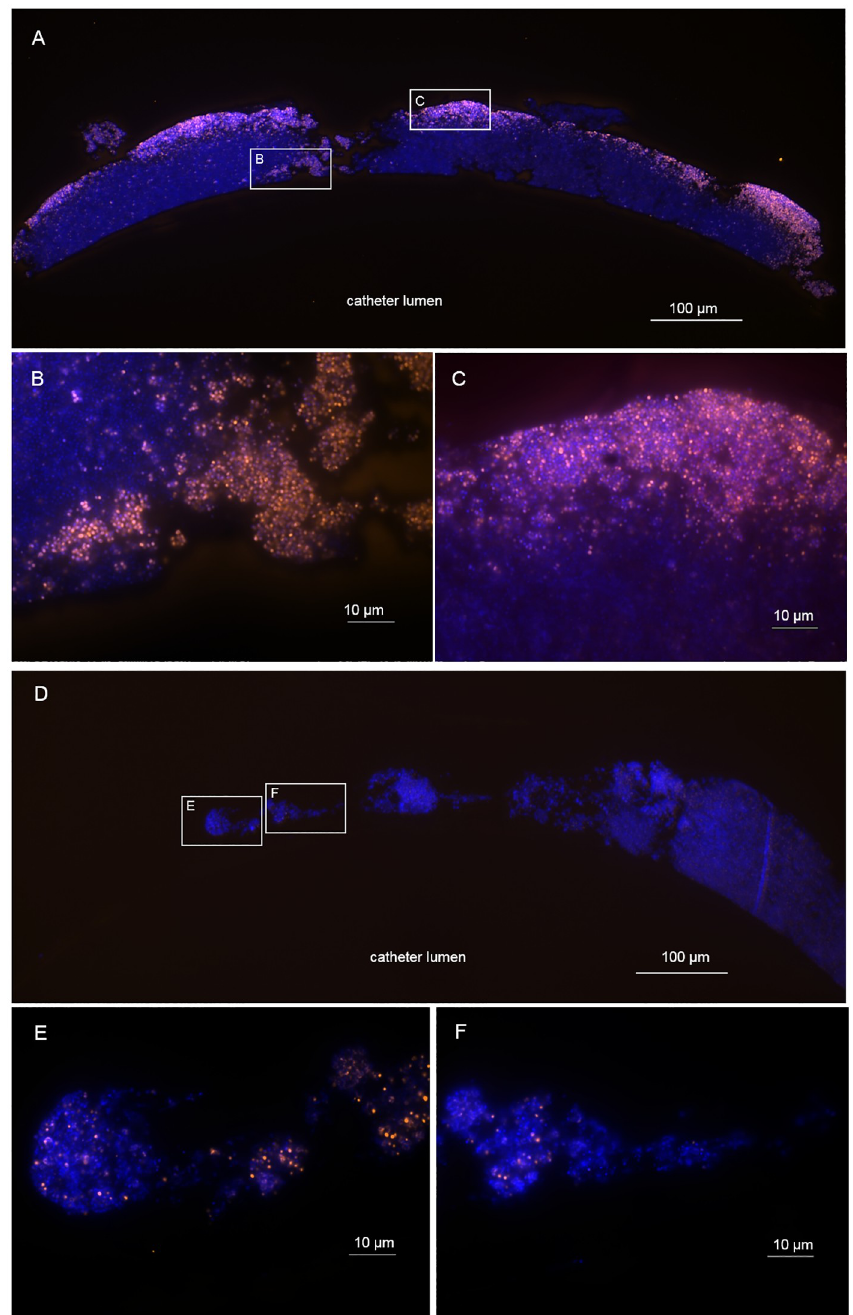
Fig 4. FISH shows differential pattern of remaining FISH-positive bacteria in biofilms and reduction of the FISH- positive fraction upon antibiotic treatment. In vitro S . epidermidis biofilm on catheter treated with vancomycin (4A-C) or daptomycin (4D-F), respectively. The blue layer represents the nucleic acid stain DAPI. The orange layer represents the FISH positive, ribosome-rich cells (Cy3). B, C are magnifications of the insets from A showing FISH- positive cocci in the outer layers of the vancomycin treated biofilm. Upon daptomycin treatment (4D-F), only single cells remain FISH-positive in all parts of the biofilm. 4E and F are magnifications of the insets from 4D showing single FISH-positive cocci remaining under daptomycin